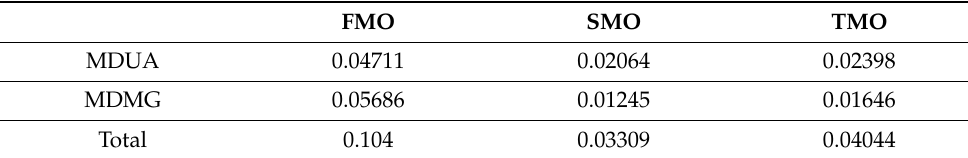
Table 8. Calculated items for the second approach. FMO